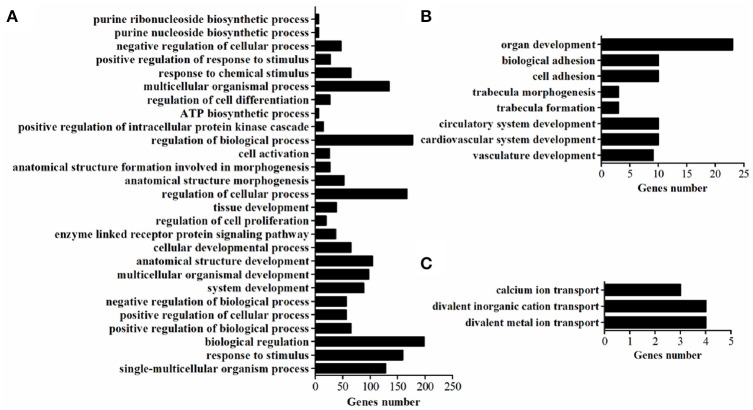
The enriched biological processes of DEGs. (A) Biological processes enriched in DEGs in WRR.D120.B-VS-WC.D120.B. (B) Biological processes enriched in DEGs in WRR.D180.B-VS- WC.D180.B. (C) Biological processes enriched in DEGs in WC.D120.B-VS-WC.D180.B.